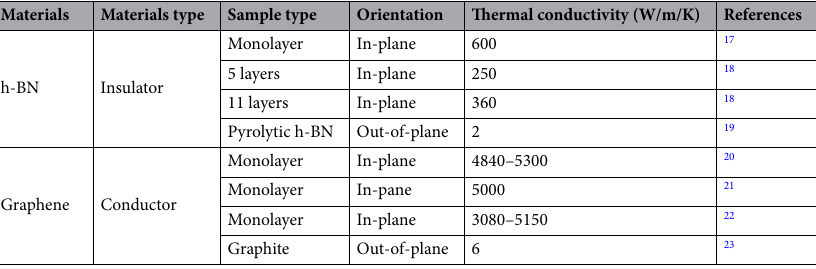
Table 1. Thermal conductivity (300 K) of h-BN and